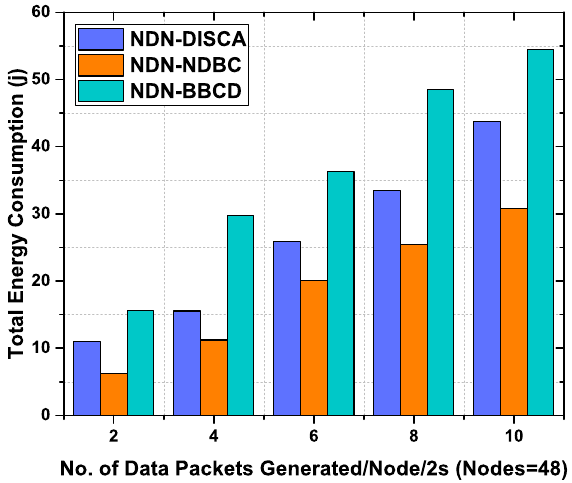
Figure 9. Total energy consumption as a function of number of data packets generated per 2 s with 48 static nodes.